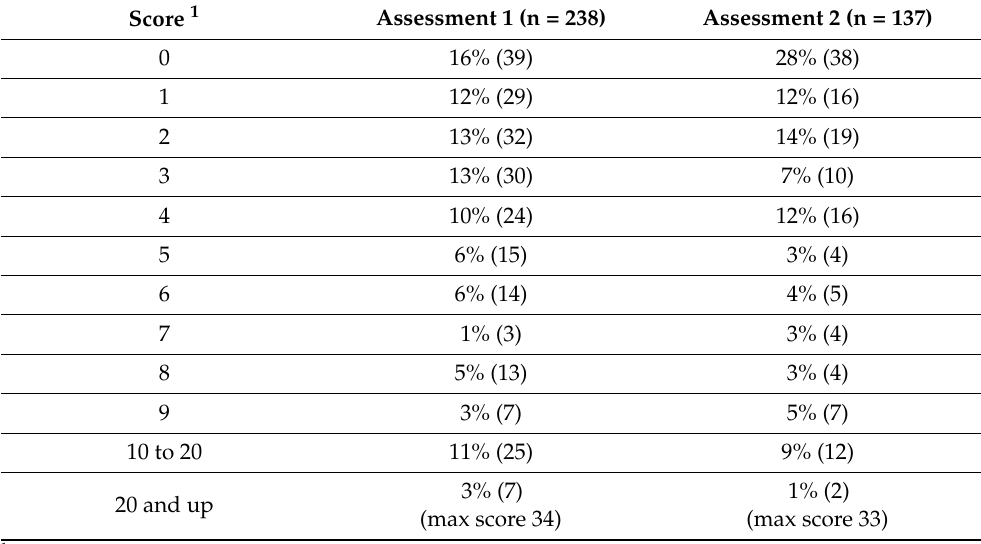
Table 3. PAIC15 assessment.